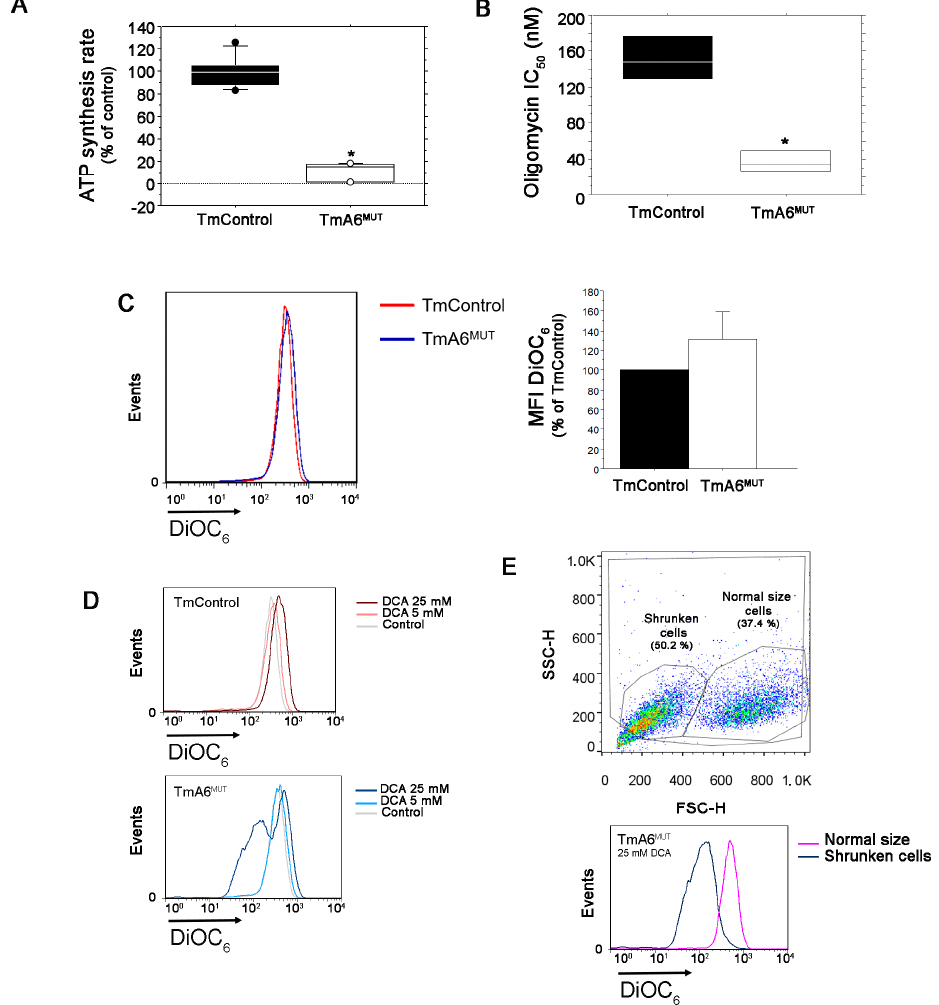
Figure 3. Analysis of mutant cells mitochondrial ATP synthesis activity and membrane potential: ( A ) ATP synthesis rate measurement in control and mutant cells ( n = 9 and 6 for control and mutant cells, respectively; p < 0.0001); ( B ) IC 50 for olygomycin in TmControl and TmA6 MUT cells ( n = 4 and p = 0.0008); ( C ) analysis of mitochondrial membrane potential ( ∆Ψ m) in control and mutant cells. Changes in ∆Ψ m were determined by staining with DiOC6 and analyzed by flow cytometry. As indicated in the legend, red histogram corresponds to TmControl cells, while blue histogram corresponds to mutant cells. The left panel shows a representative histogram of ∆Ψ m measurement in both cell lines under basal conditions (the further to the right the peak is, the higher the membrane potential) whereas the right panel represents the average ∆Ψ m of mutant cells relative to controls from two independent experiments; ( D ) ∆Ψ m evaluation in both cell lines after treatment with different concentrations of DCA; and ( E ) Mutant cells were further separated into different populations, depending on their size (normal size and shrunken, left), and their corresponding ∆Ψ m was compared (right). All values are given as mean ± SD of the mean. Asterisks indicate significant differences respect to control cells, tested by ANOVA post-hoc Fisher PLSD ( p < 0.05 or as